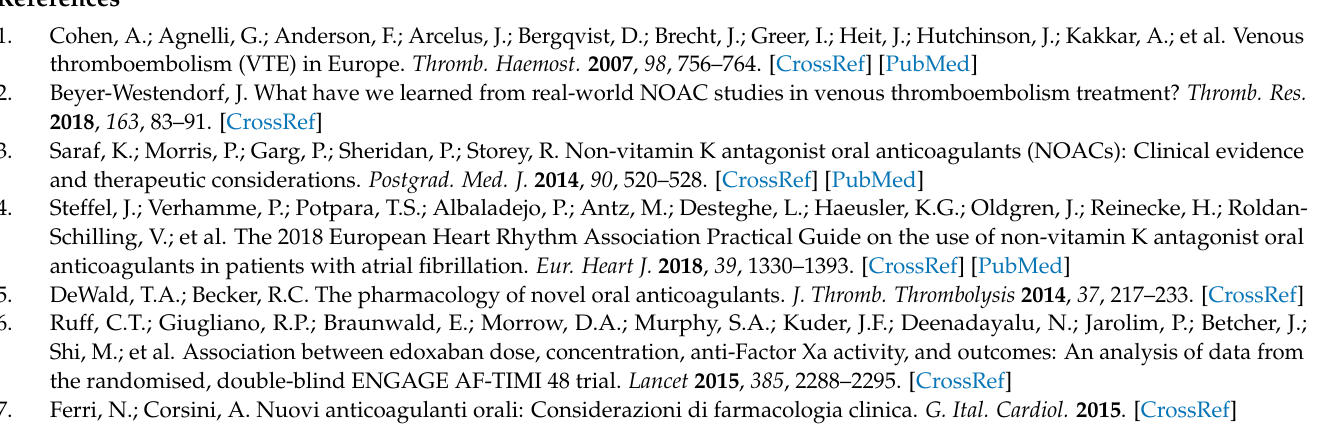
data. Table S1: ICD9-CM codes considered in the analysis. Table S2: Aggregated diagnosis of resignation 2017 and related incidence: patients treated with NOACs. Table S3: Aggregated diagnosis of resignation 2018 and related incidence: patients treated with NOACs. Table S4: Aggregated diagnosis of resignation 2017 and related incidence: patients treated with VKAs. Table S5: Aggregated diagnosis of resignation 2018 and related incidence: patients treated with